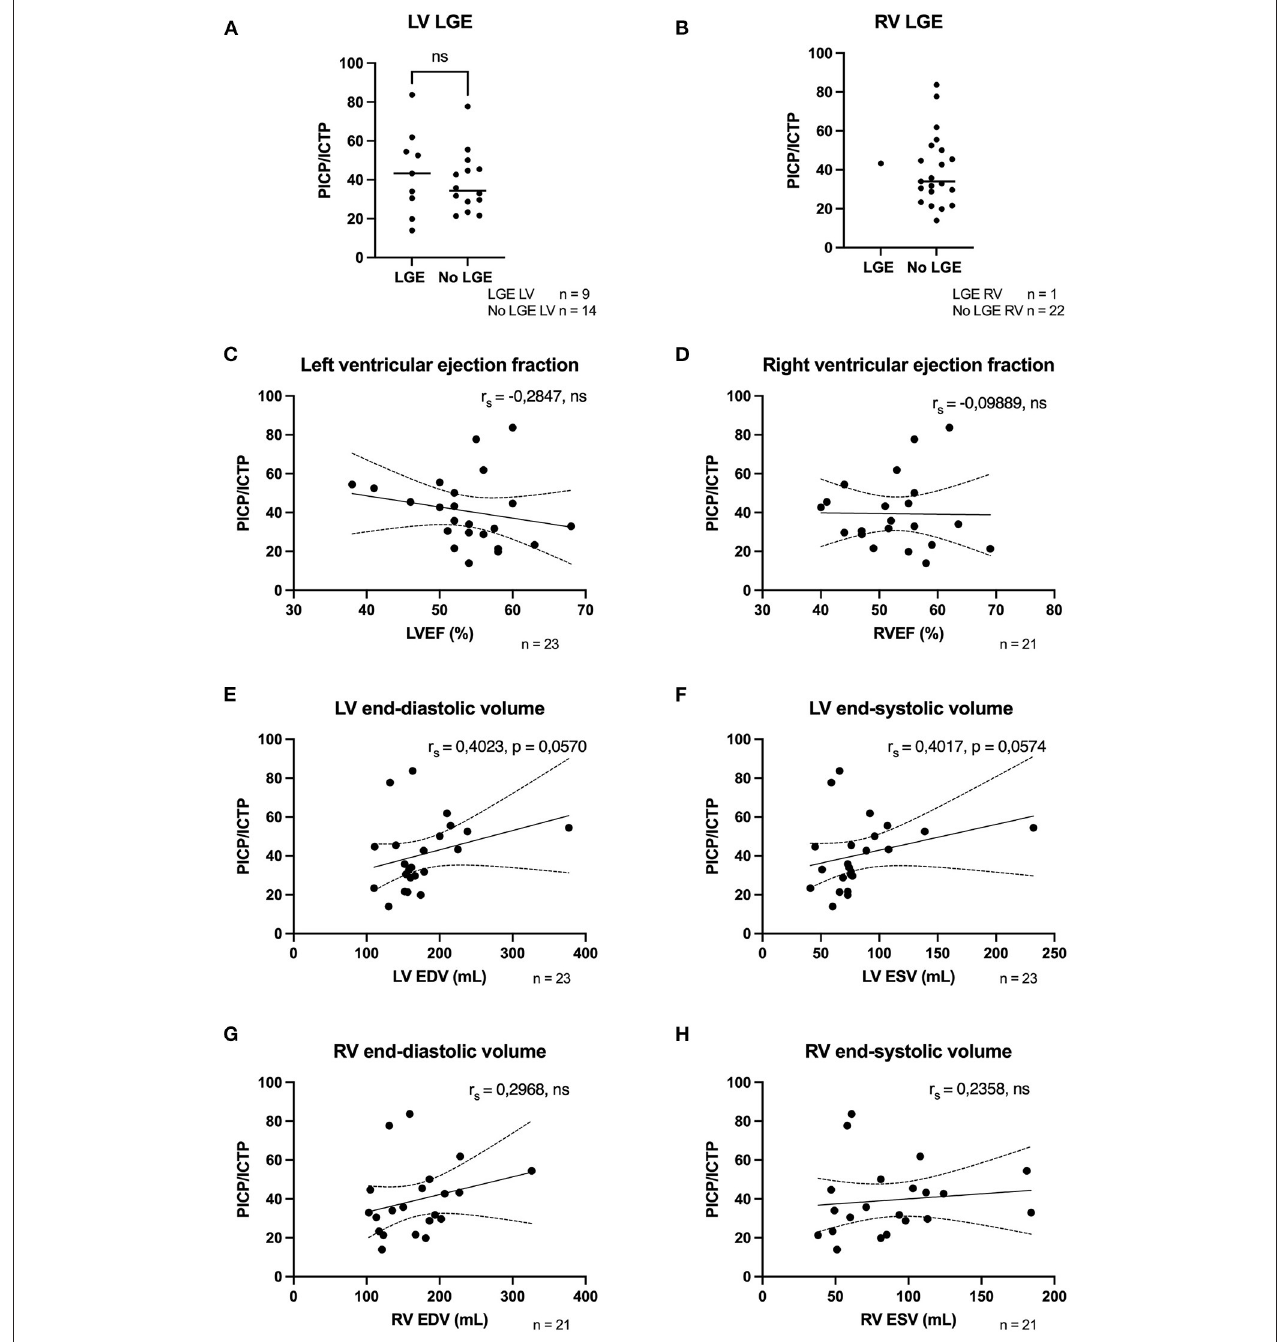
FIGURE 1 | Fibrosis biomarkers correlated weakly to moderatly to structural/functional parameters. (A) PICP/ICTP ratio was not different in patients with LV LGE ( n = 9) compared to patients who did not have LV LGE ( n = 14). (B) Only one patient had LGE in the RV, therfore no comparison could be made. (C) A weak negative correlation was found with LVEF ( n = 23). (D) No correlation was found with RVEF and fibrosis biomarkers ( n = 21). (E,F) Moderate positive correlations were found with LV EDV and ESV ( n = 23). (G,H) Weak positive correlations were found with RV EDV and ESV ( n = 21). LGE, late gadolinium enhancement; LVEF, left ventricular ejection fraction; RVEF, right ventricular ejection fraction; EDV, end-diastolic volume; ESV, end-systolic volume; PICP, procollagen type I carboxy-terminal pro-peptide; ICTP, C-terminal telopeptide collagen type I; rs, Spearman’s rho; ns, not significant.